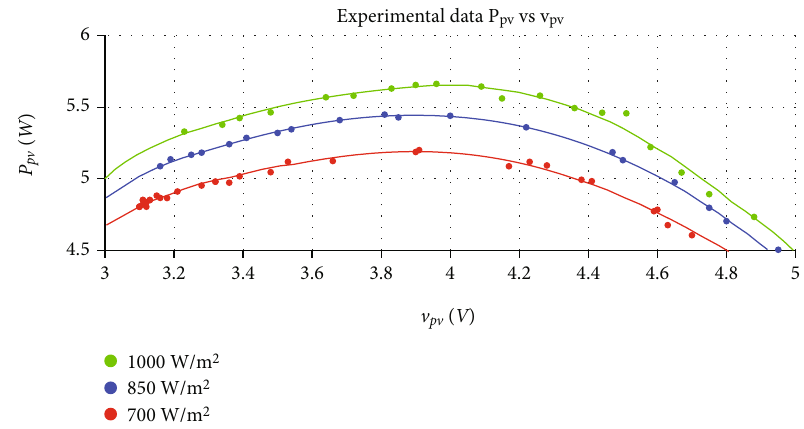
Figure 8: Experimental measurement of the PV cell output power function P